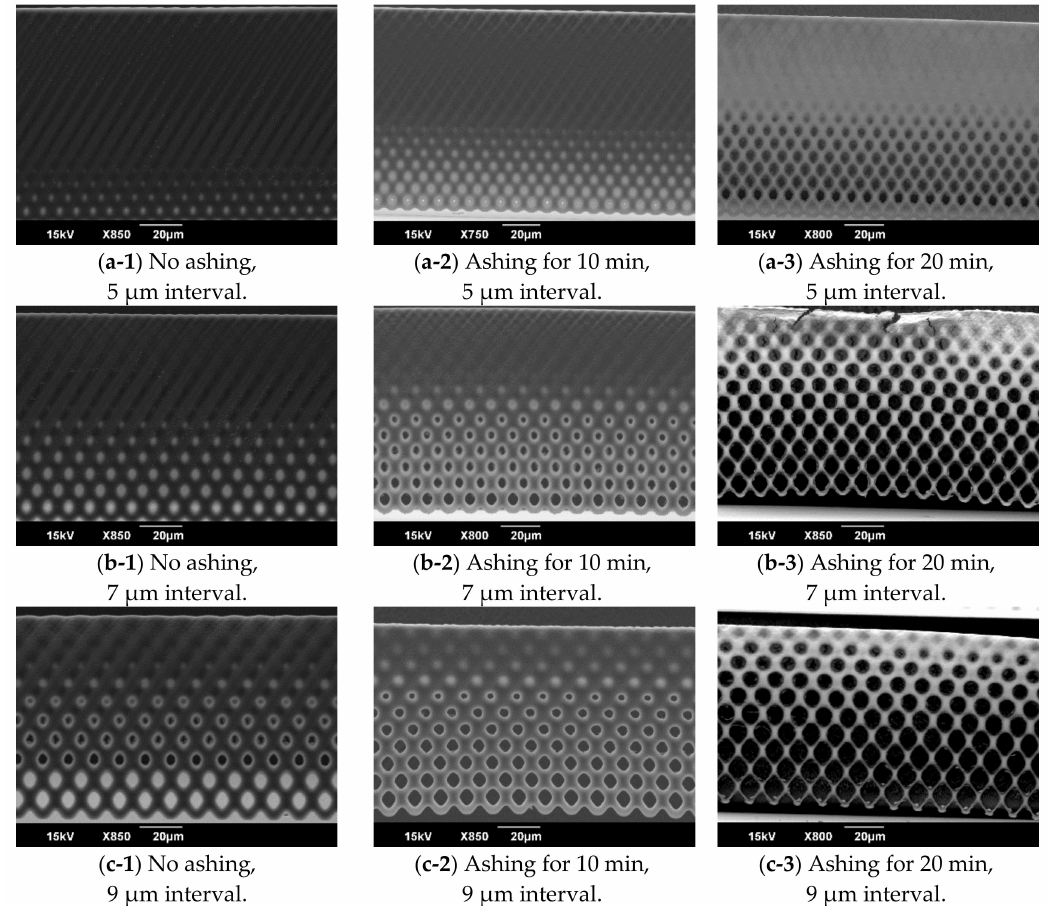
Figure 7. SEM images of the vertical porous membrane inclined oxygen ashing. To evaluate the effect of the inclined oxygen ashing, a fabricated vertical porous membrane with a dot size of 3 µ m was